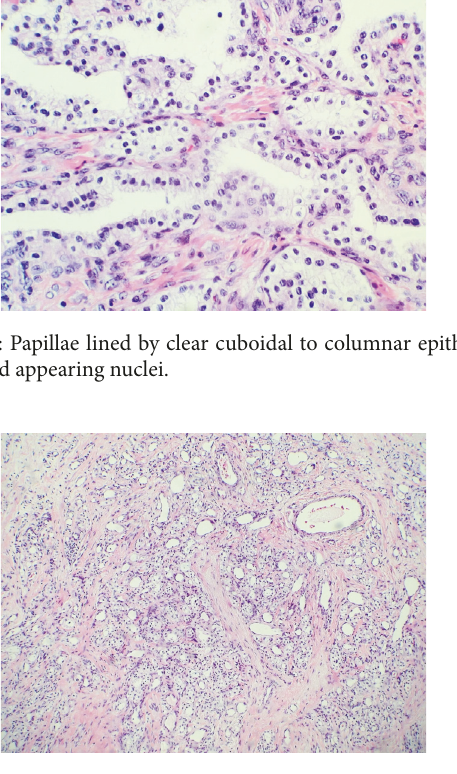
Figure 4: Lesion composed of small cystic spaces adjacent to papillary